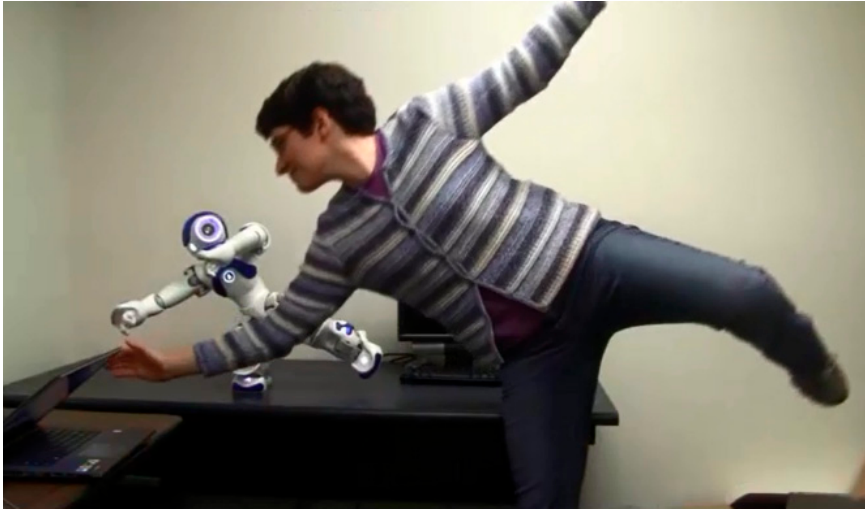
Figure 3. Dance freeze game for kids with autism spectrum disorders. Participants experienced human partner and robot partner for the game.